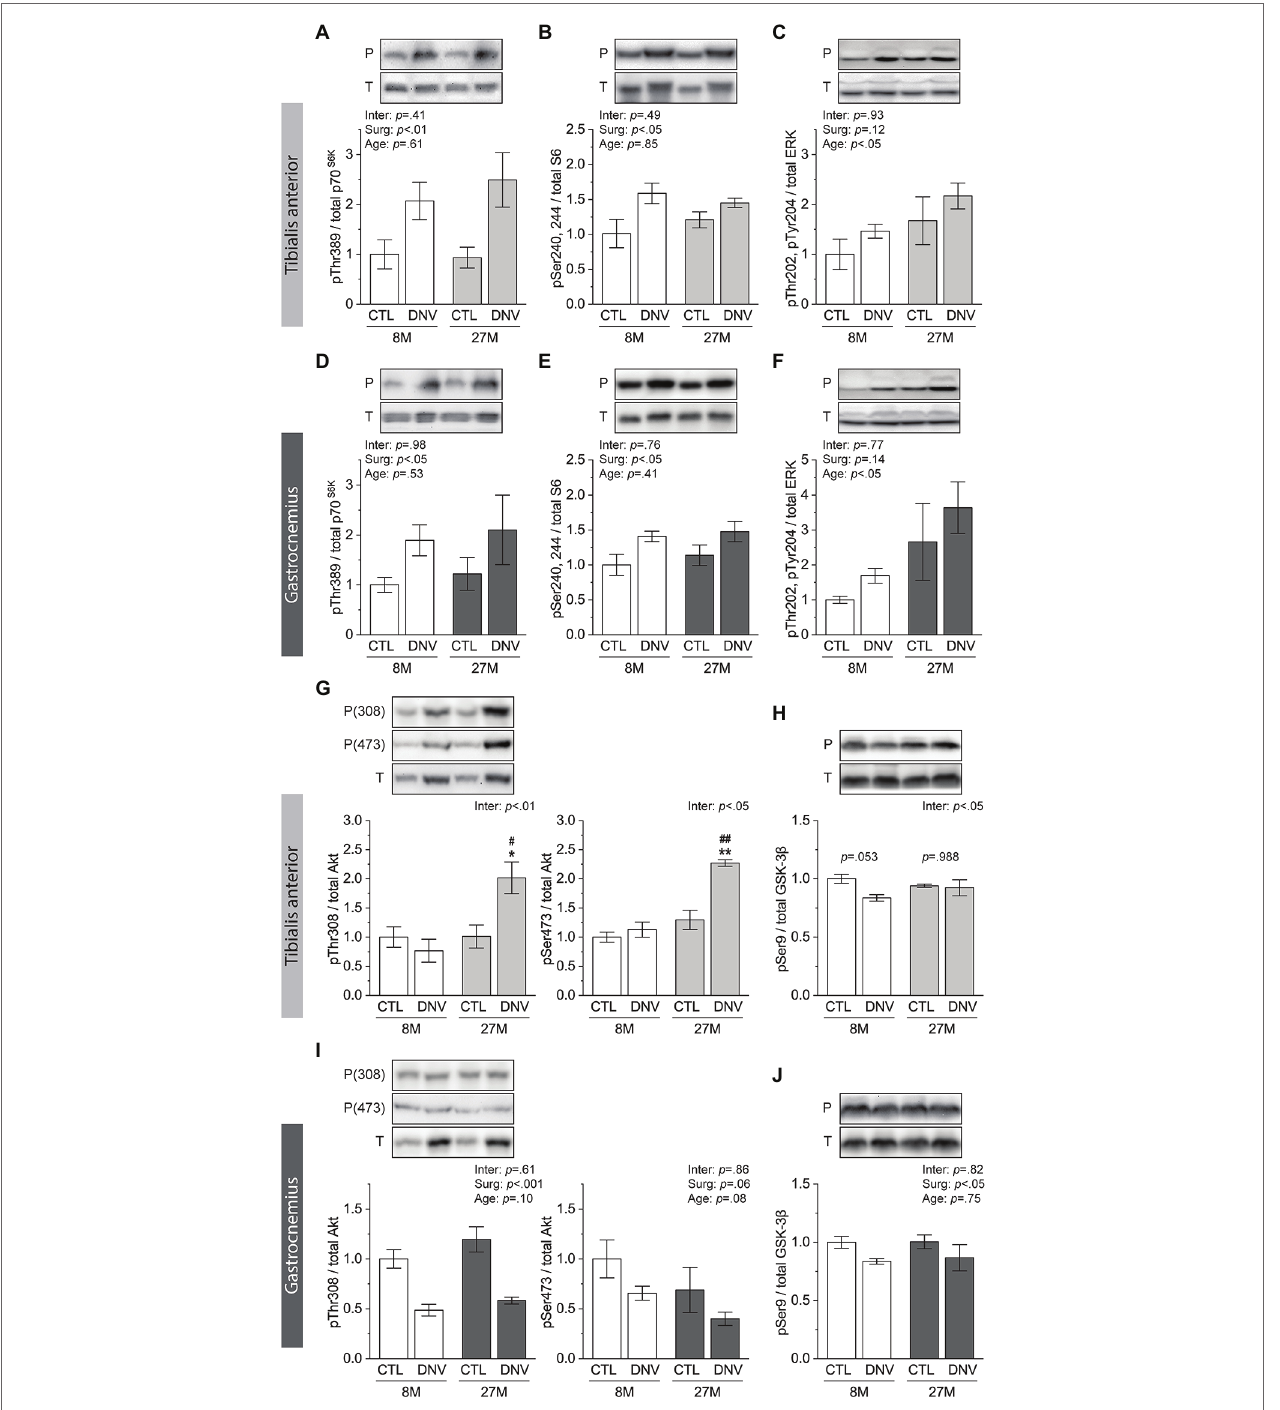
FIGURE 4 | Effects of aging on mammalian target of rapamycin complex 1 (mTORC1), ERK, and Akt signaling during muscle denervation. Mice at 8 months (8 M) and 27 months (27 M) of age were subjected to denervation (right leg, DNV) and sham (contralateral left leg, CTL) surgeries, and TA and GAST muscles were collected 7 days post-surgeries. (A–C) Quantification of Western blots for phosphorylated (P)/total (T) ratios of p70 S6K (A) , S6 (B) , and ERK (C) in TA. (D–F) Quantification of Western blots for phosphorylated (P)/total (T) ratios of p70 S6K (D) , S6 (E) , and ERK (F) in GAST. (G,H) Quantification of Western blots for phosphorylated (P)/total (T) ratios of Akt (G) and glycogen synthase kinase-3 β (GSK-3 β ; H ) in TA. (I,J) Quantification of Western blots for phosphorylated (P)/total (T) ratios of Akt (I) and GSK-3 β (J) in GAST. n = 5–3 mice/group. Data are presented as mean ± SEM. and expressed relative to 8 M/CTL. * p < 0.05 and ** p < 0.01 vs. CTL by two-way mixed ANOVA. # p < 0.05 and ## p < 0.01 vs. 8 M within the same surgery groups by two-way mixed ANOVA. Inter, interaction between surgery effects (Surg) and age effects by two-way mixed